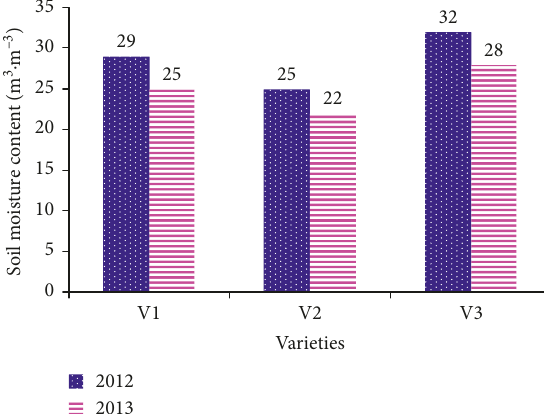
Figure 6: Average soil moisture content determined from the different sampling periods in response to the three tef varieties in 2012 and 2013 cropping seasons. Note: for tef varieties: V1, Sergen ; V2, DZ-cr-387 or Kuncho ; V3, Keyih. Table 8: Paired mean difference comparison and correlation analyses results of soil moisture content response to the average of all fertilizer rates and tef varieties combined effects at the same sampling time between 2012 and 2013 in northern Ethiopia ( n � 36). Paired mean comparison Correlation Paired moisture content Mean difference df Significance